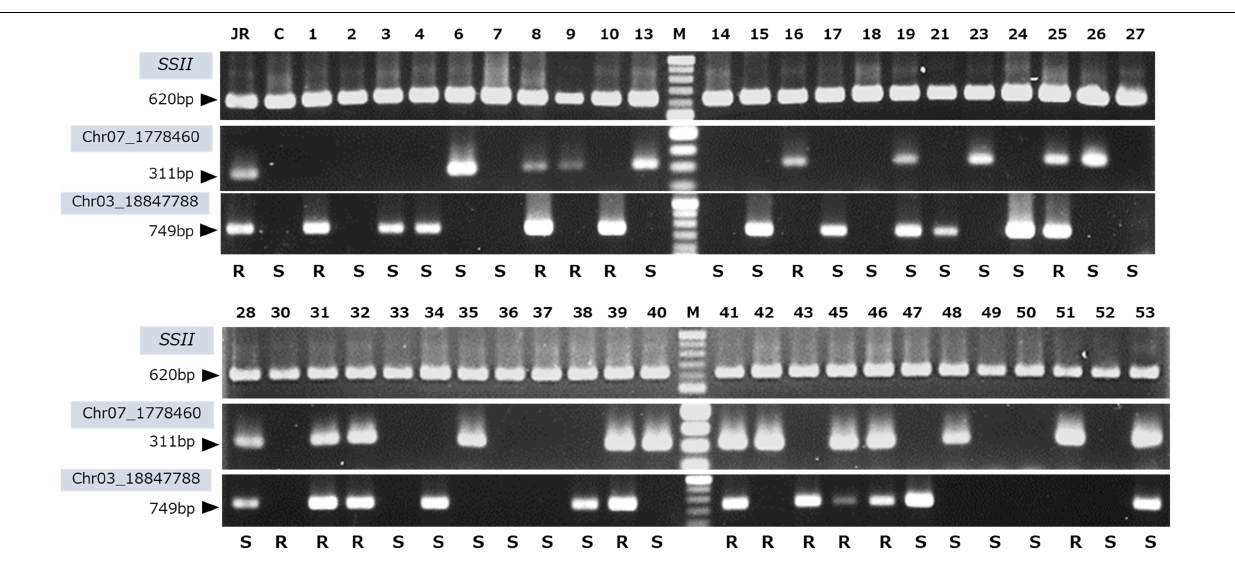
FIGURE 6 | PCR genotyping using the developed DNA markers derived from the Chr07_1778460 and Chr03_18847788 SNPs. SSII , positive control; JR, J-Red; C, Choshu, 1-53, F 1 lines; and M, 100 bp DNA ladder. The evaluation of the resistance to the SP2 race is shown on bottom of each lane. R and S indicates resistance and susceptibility,